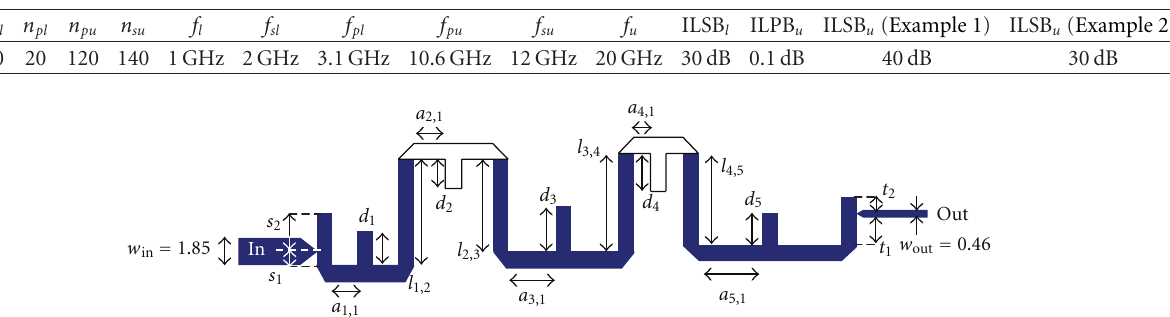
Table 1: Filter design specifications for Examples 1 and 2.